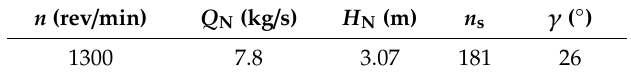
Table 2. Key characteristic parameters at design point under pump